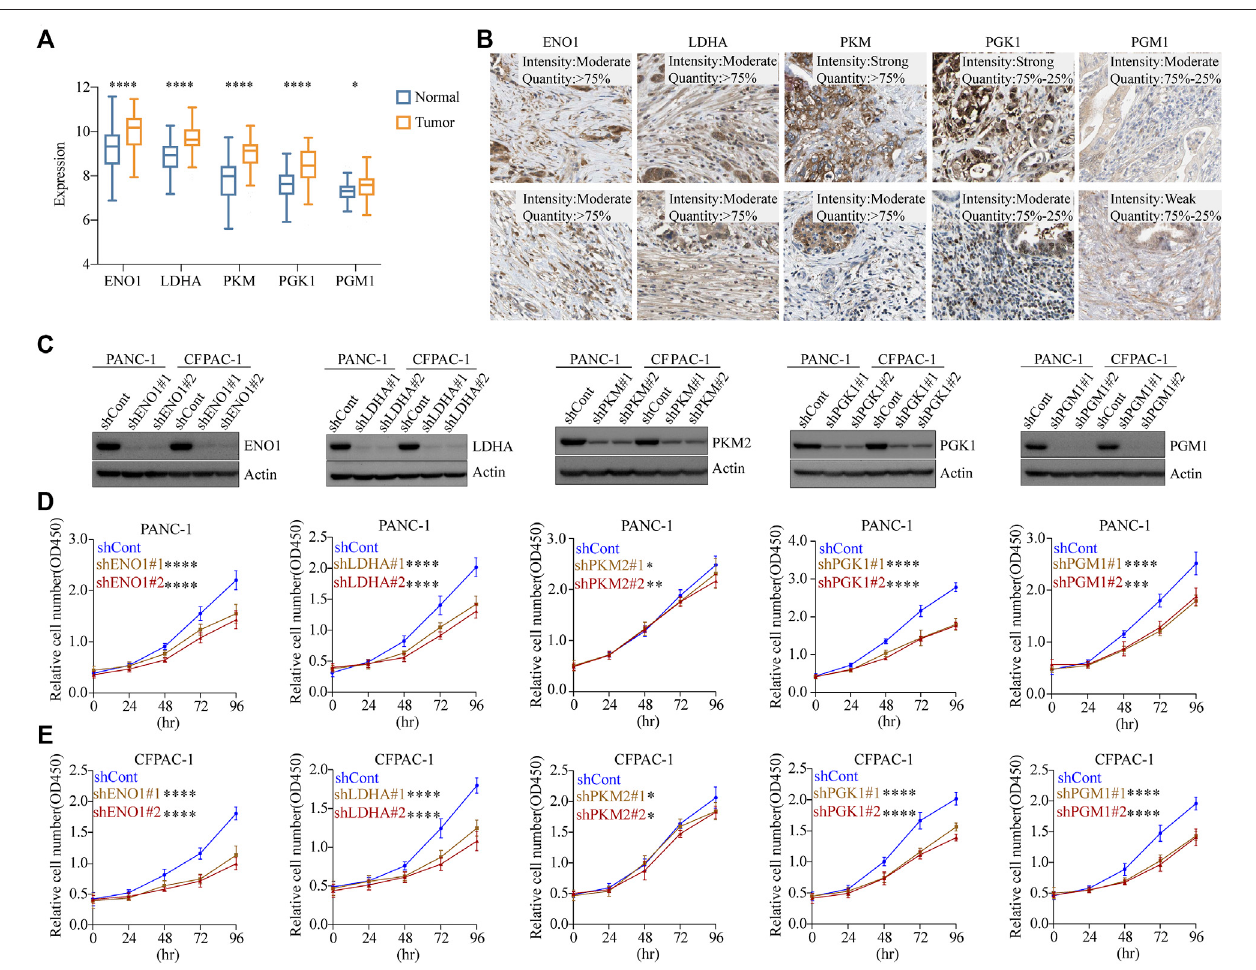
FIGURE4| GlycolyticmarkergenesinvolvedinthemalignantprogressionofPDAC. (A) Expressionlevelsof fi veglycolyticmarkergenesbetweentumorandpaired normal tissues in the GSE62452 cohort. Blue, normal; orange, tumor. (B) Expression levels of EN O 1 , LDHA , PKM , PGK1 , and PGM1 protein in 10 patients with PDAC from the HPA database. Scale bar: 20 µm. (C) PANC-1 cells and CFPAC-1 cells were transfected with sh-control, sh-ENO1, sh-LDHA, sh-PKM2, sh-PGK1, and sh- PGM1. Validation of knockdown ef fi ciency using Western blot. (D) PANC-1 cells viability was measured by CCK8 assay after knockdown of fi ve glycolytic marker genes,respectively. (E) CFPAC-1cells viabilitywasmeasured byCCK8assayafter knockdown of fi veglycolytic markergenes,respectively. * p < 0.05; ** p < 0.01; *** p < 0.001; **** p < 0.0001.